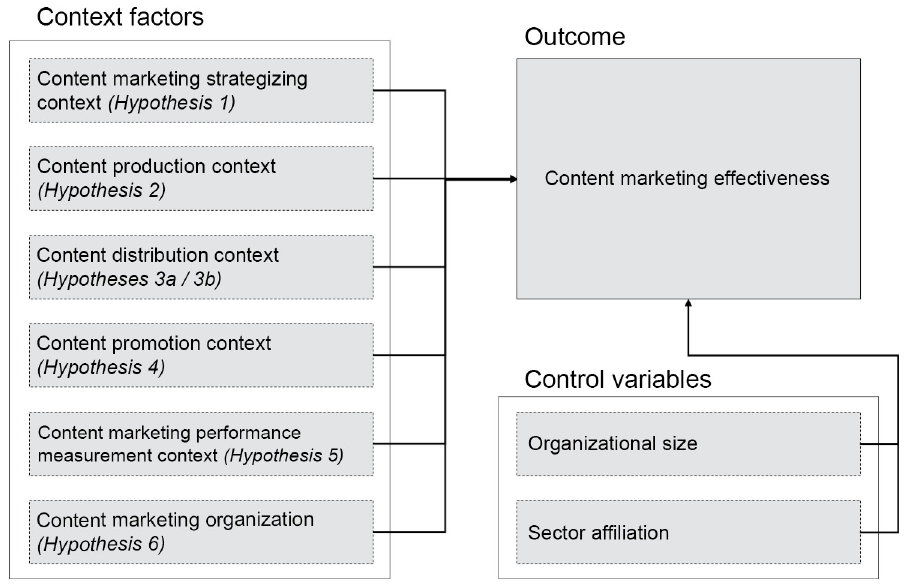
Fig 1. A model of the determinants of content marketing